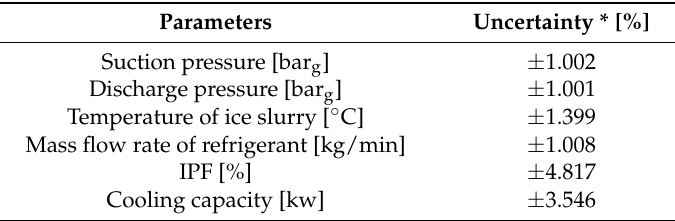
Table 4. Parameters and estimated uncertainties.